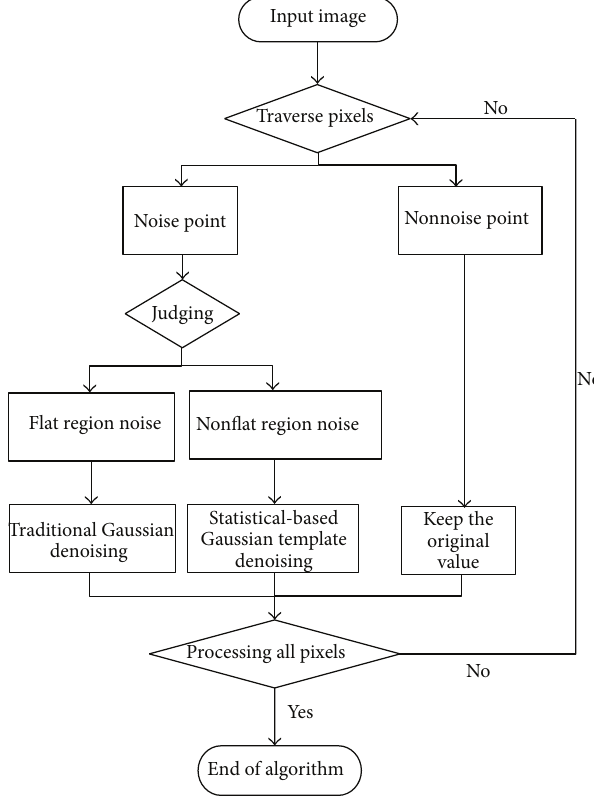
Figure 3: Algorithm flow.